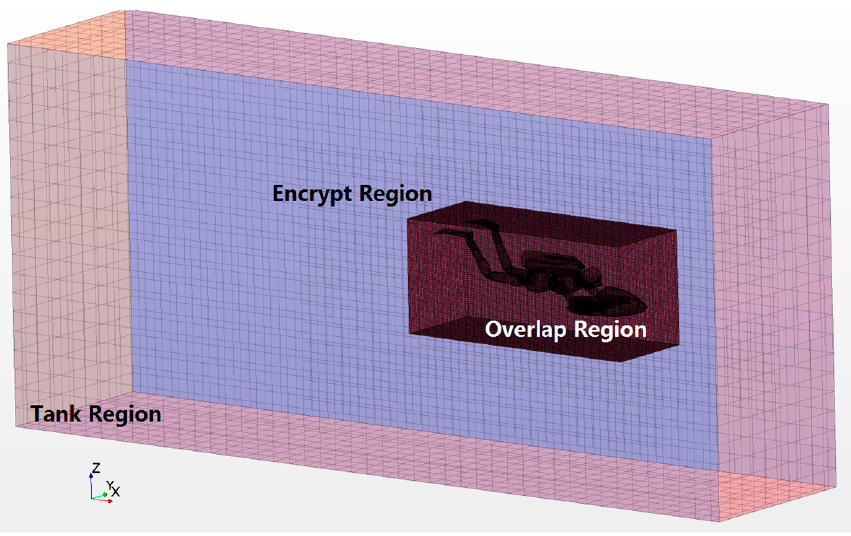
Figure 9. Calculation regions of water tank.